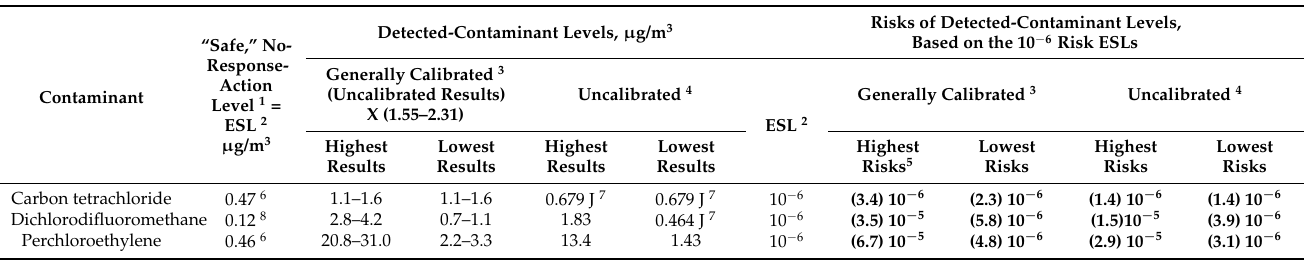
Table 6. Violations of the First Safety Benchmark, No “Response-Action” Levels or Environmental Screening Level (ESLs), Indoor Air, Former Naval Ordnance Testing Station, Pasadena, California (NOTSPA). Bold =